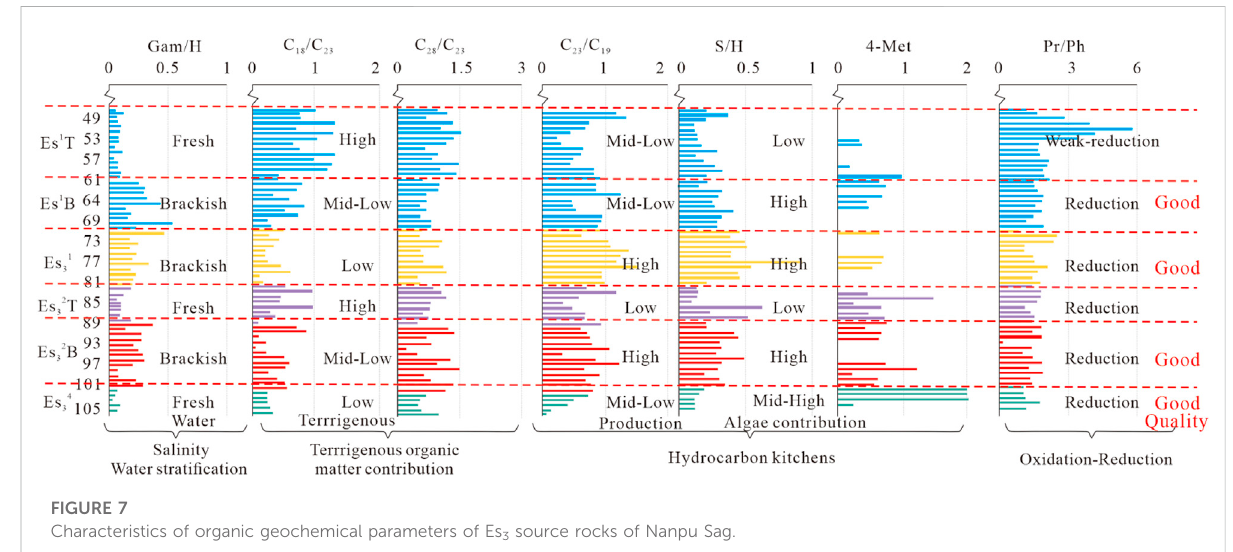
FIGURE 7 Characteristics of organic geochemical parameters of Es 3 source rocks of Nanpu Sag.